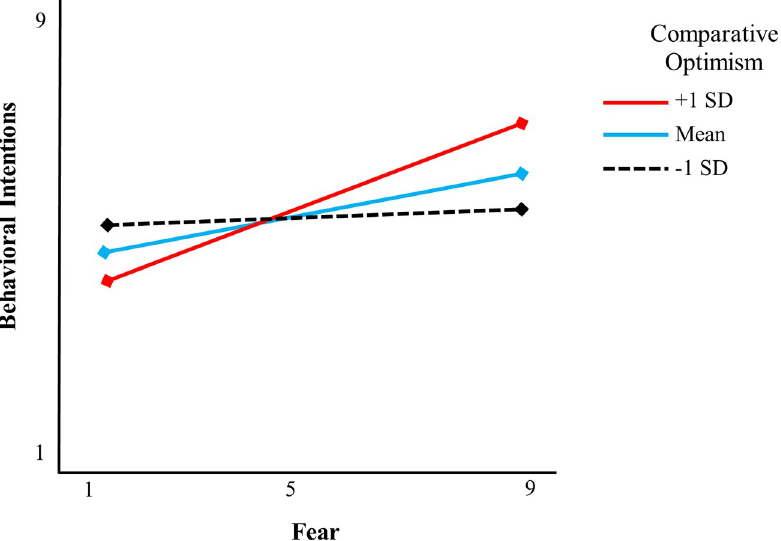
Fig 2. Interactions between fear and comparative optimism for current smokers on behavioral